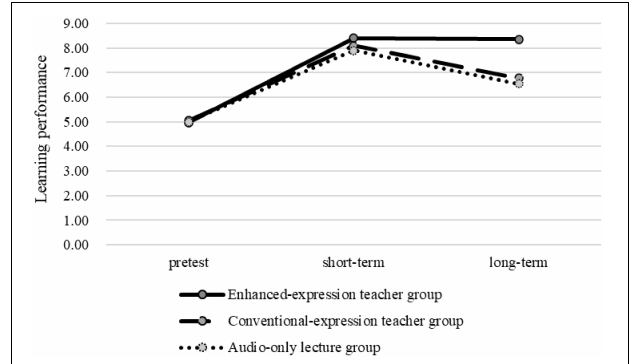
FIGURE 3 | Pretest and posttest outcomes of the three groups.